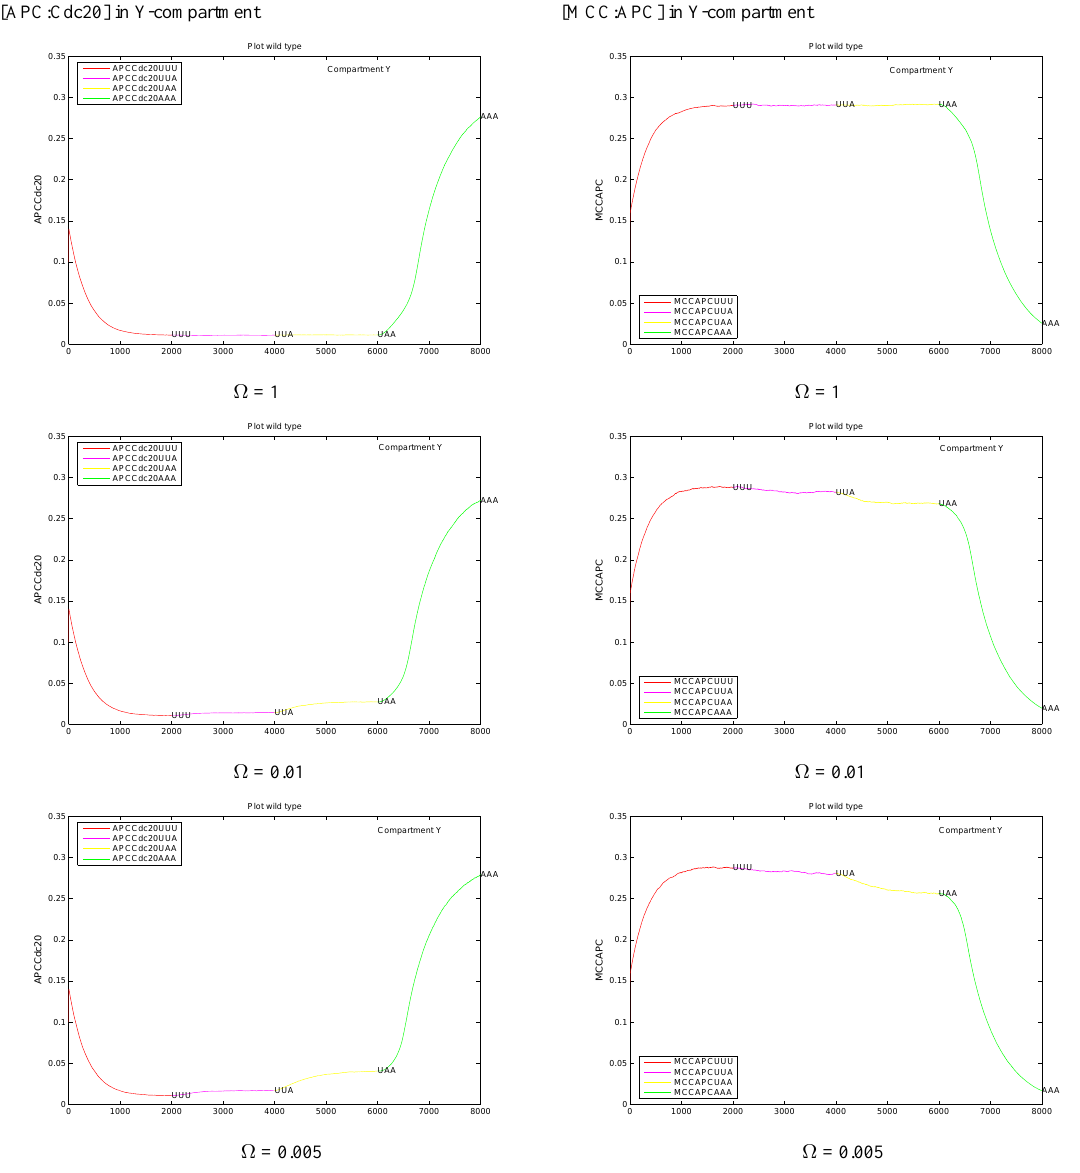
Figure 3: Concentration of APC:Cdc20 (left) and MCC:APC (right) as a function of time (8000 iterations corresponding to 12 min) in the middle compartment Y at noise amplitude N = 10 − 8 . The first part (orange, from time 0 to ’UUU’) of the curves describes the phase with three kineto- chores Unattached (UUU); the second part (red, ’UUU’-’UUA’), the phase with two kinetochores Unattached and one Attached (UUA); etc. (cf. insert). With decreasing diffusion coefficient Ω (cf. text), the concentration differences within the 3 phases UUU, UUA, UAA, increase more and more. Steady state is reached after at most 3 min. When all kinetochores are attached (green curve ’UAA’-’AAA’, phase AAA), APC:Cdc20 rises immediately and MCC:APC